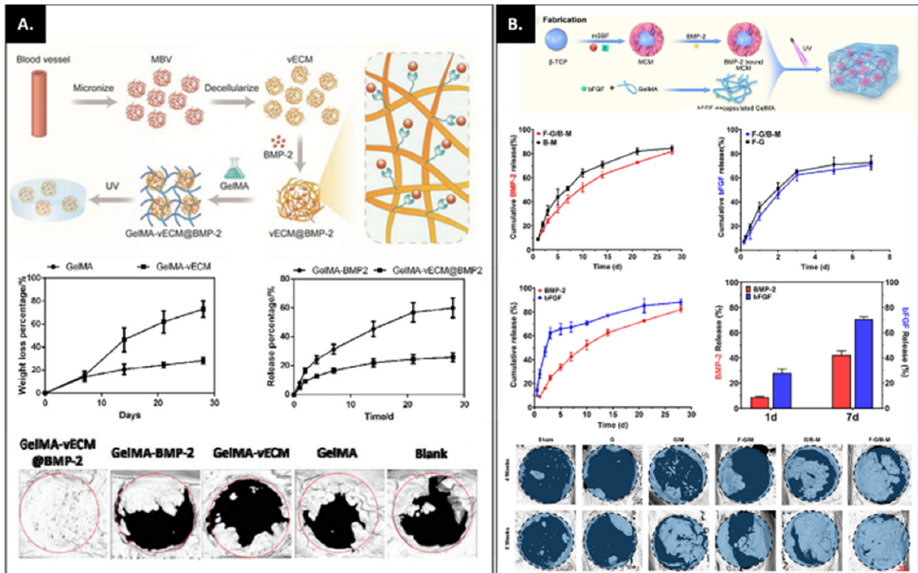
Figure 3. ( A ) Incorporation of vascular-derived extracellular matrix (vECM)@BMP-2 into GelMA hydrogels for angiogenic induced bone regeneration. The top panel shows a schematic diagram of GelMA-vECM@BMP-2 composite hydrogels. The middle panel represents the degradation of GelMA and GelMA-vECM hydrogels and the release patterns of BMP-2 from those hydrogels. The bottom panel shows an excellent bone regeneration ability of GelMA-vECM@BMP-2 hydrogel. Adapted BMP-2 from GelMA-based hydrogels. The top panel shows a schematic illustration of the fabrication of bFGF-GelMA (F-G)/BMP-2-MCM (B-M) composite hydrogels. The middle panel represents the release kinetics of bFGF and BMP-2. The bottom panel demonstrates that the dual release of